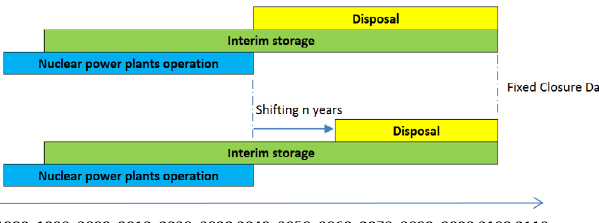
Fig. 10. n -Year delay of DGR deployment with an unchanged closure